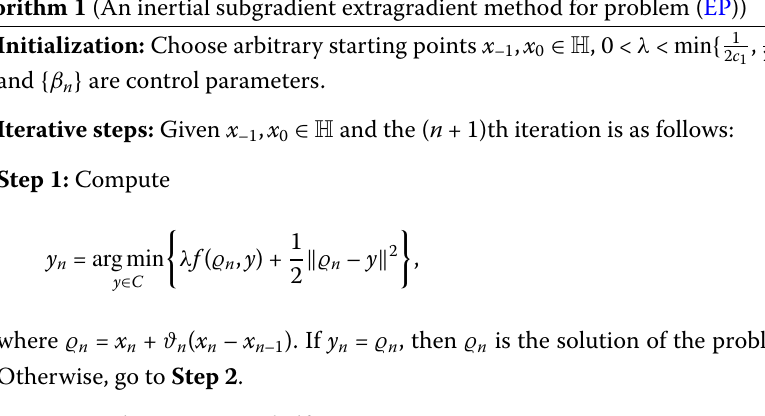
Algorithm 1 (An inertial subgradient extragradient method for problem